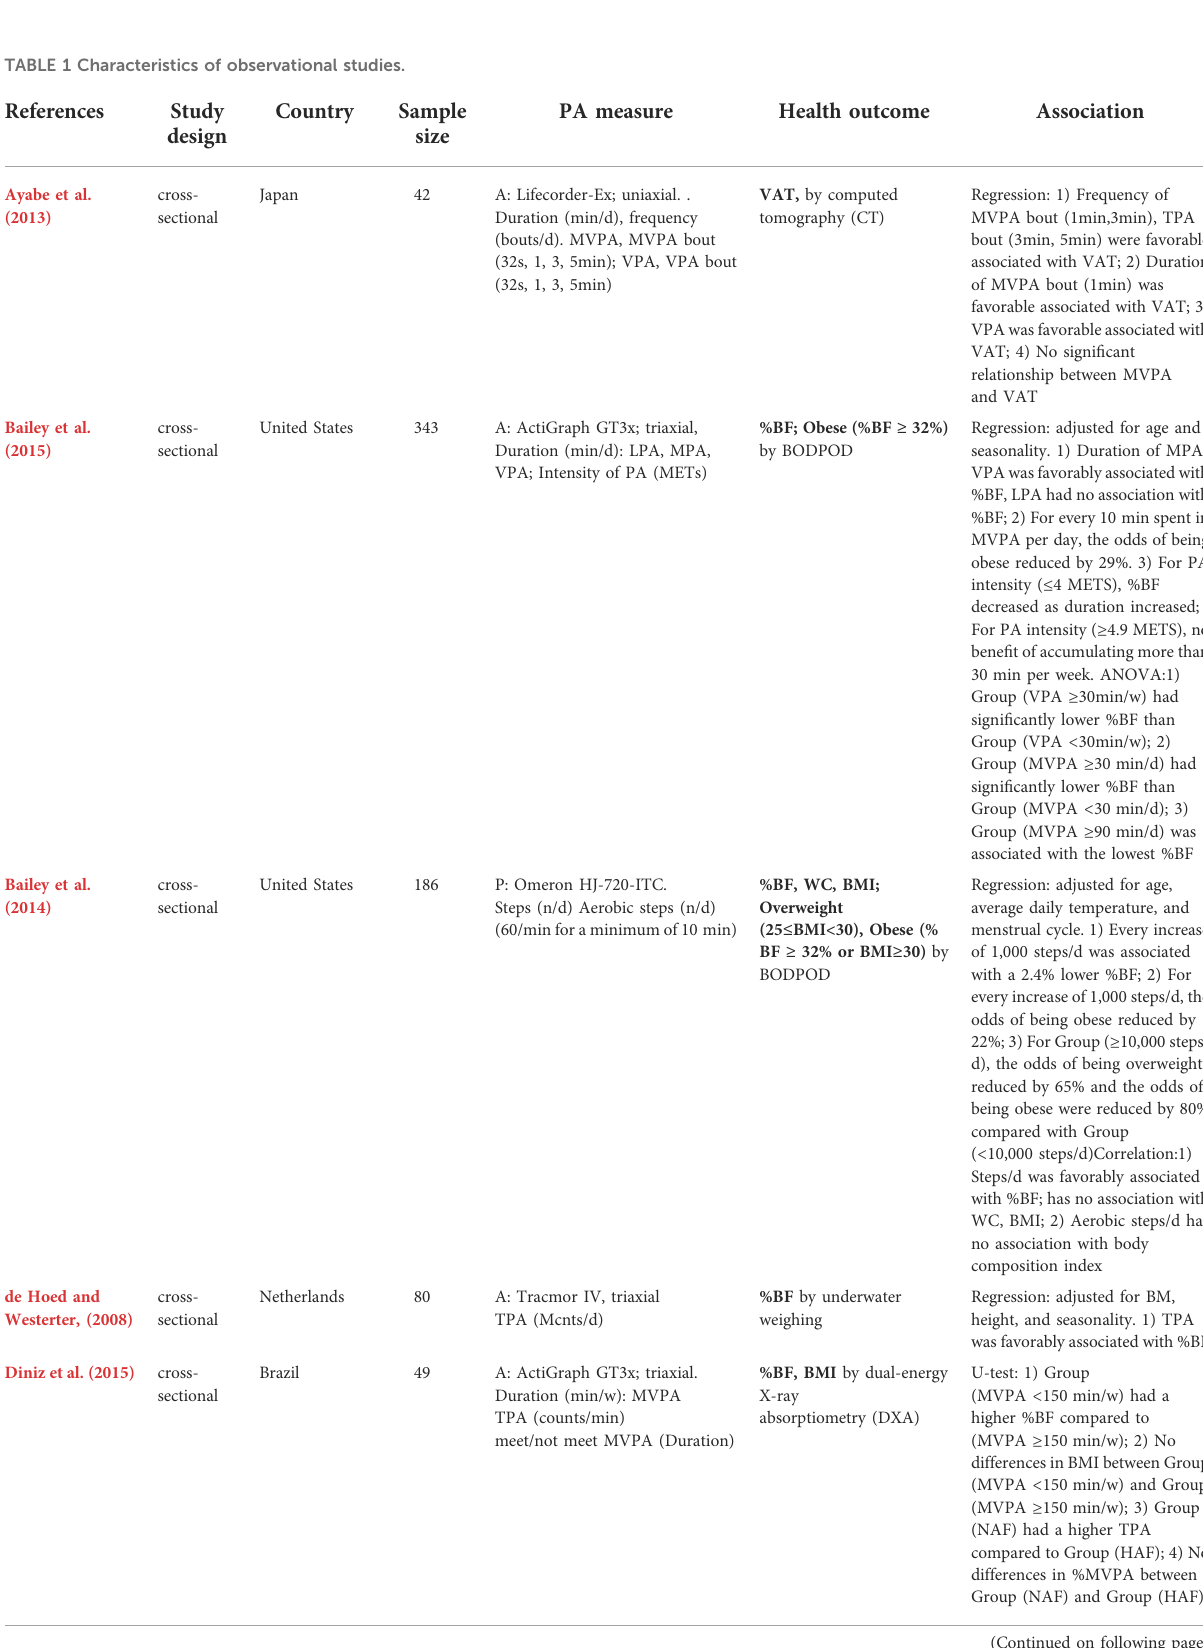
TABLE 1 Characteristics of observational